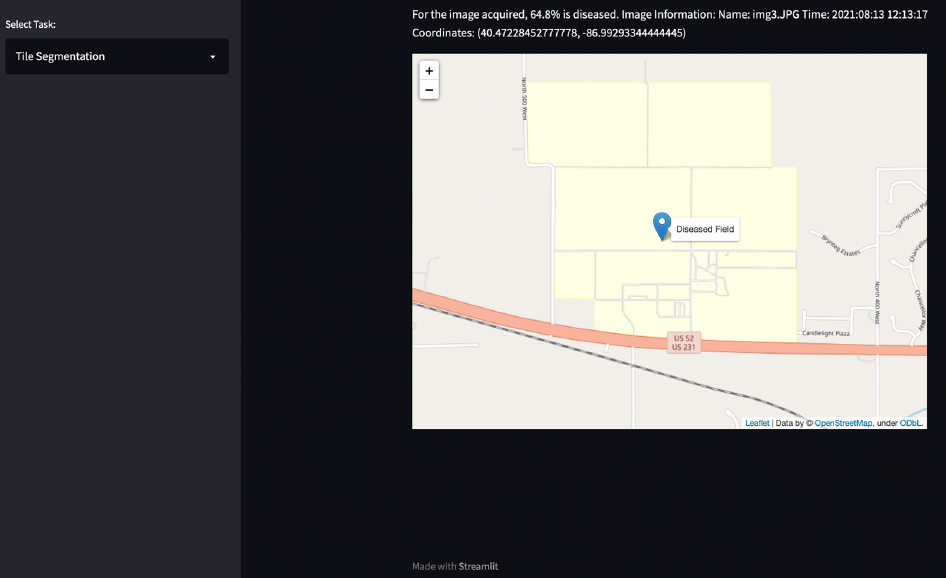
Figure 13. Pinpoint diseased regions on maps using RTK geolocation information.